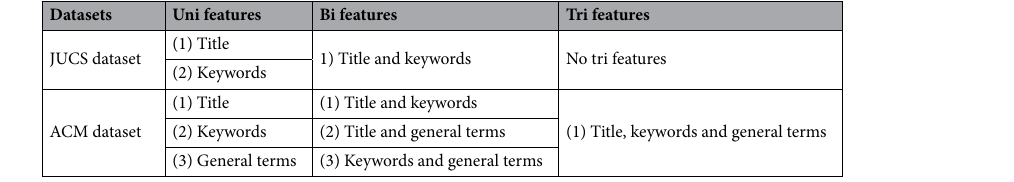
Table 2. Possible combination.